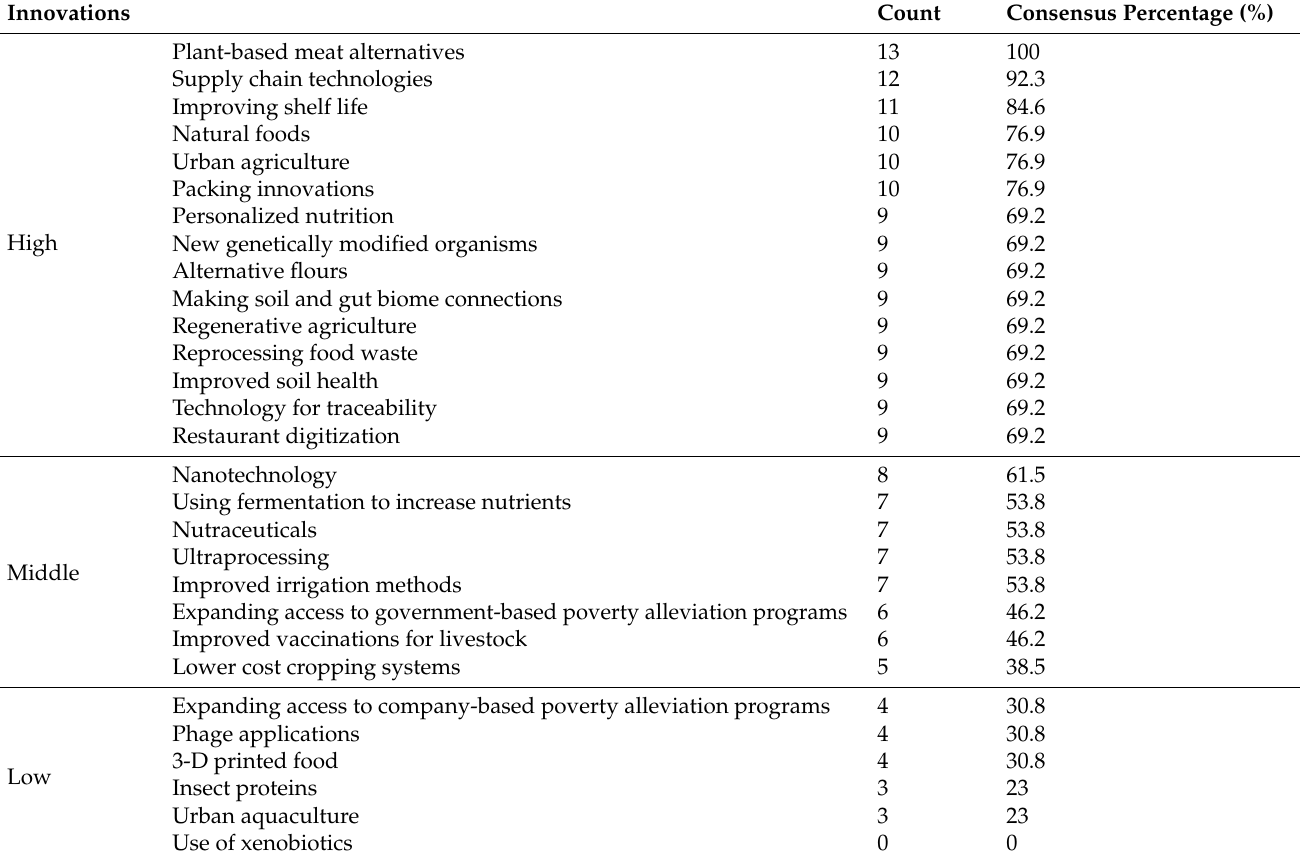
Table 2. Specific food innovations likely to be available to consumers by